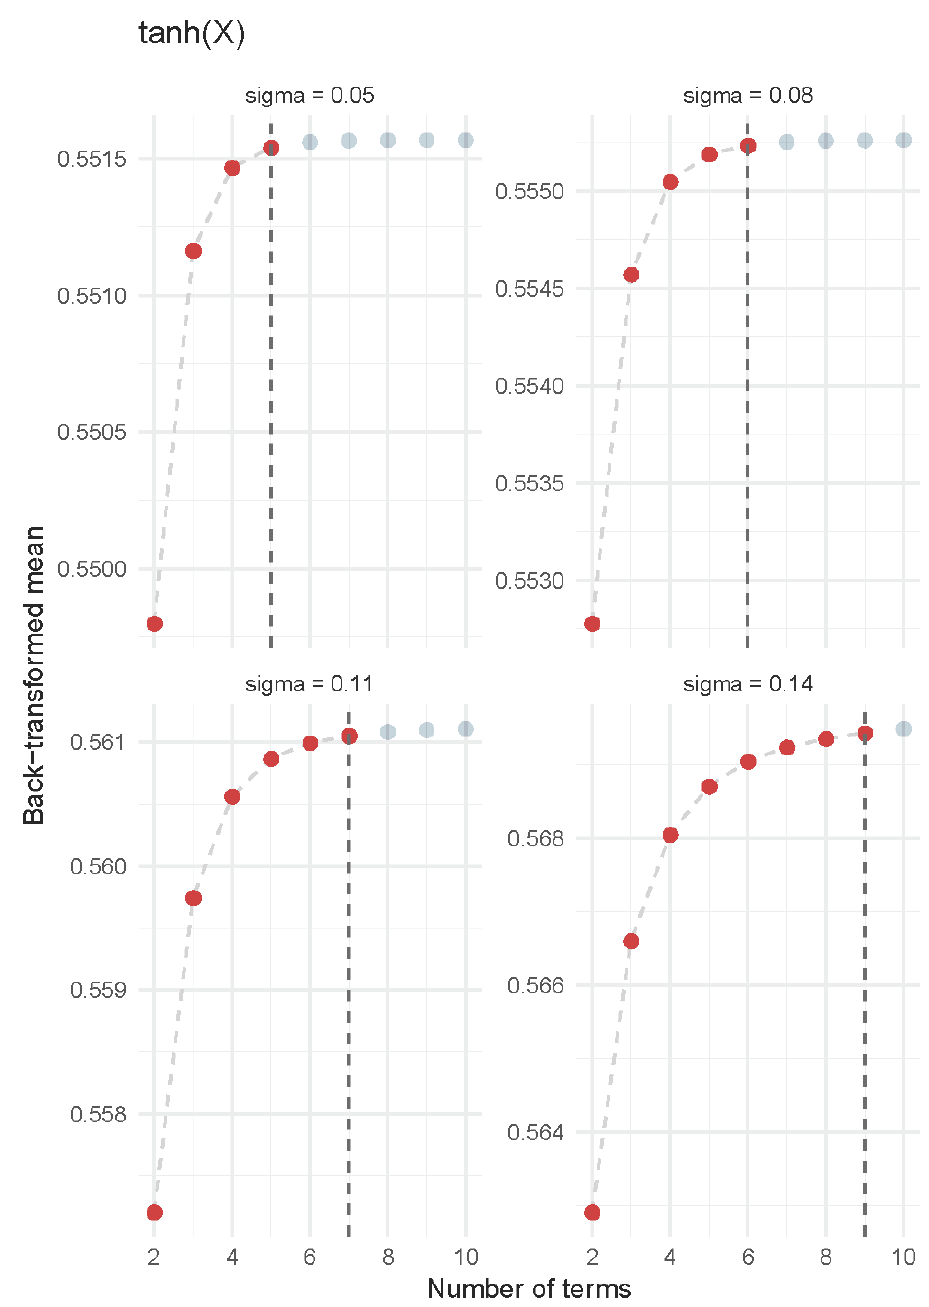
Figure 8. Convergence of the hyperbolic tangent transformation according to the number of terms in Table 1.